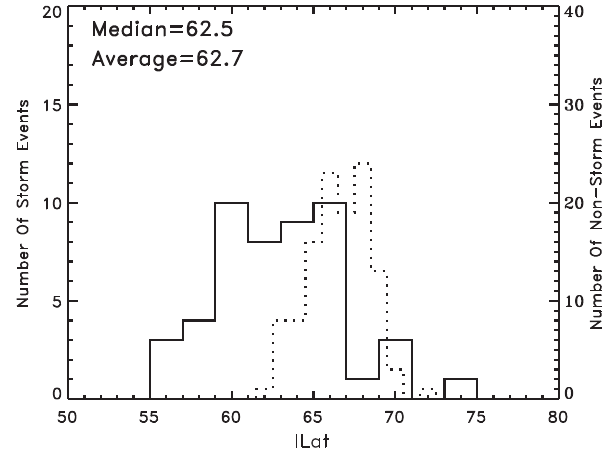
Fig. 4c. Histogram of onset locations as a function of ILat. Super- imposed is a similar histogram for isolated substorms (from Gjer- loev et al.,